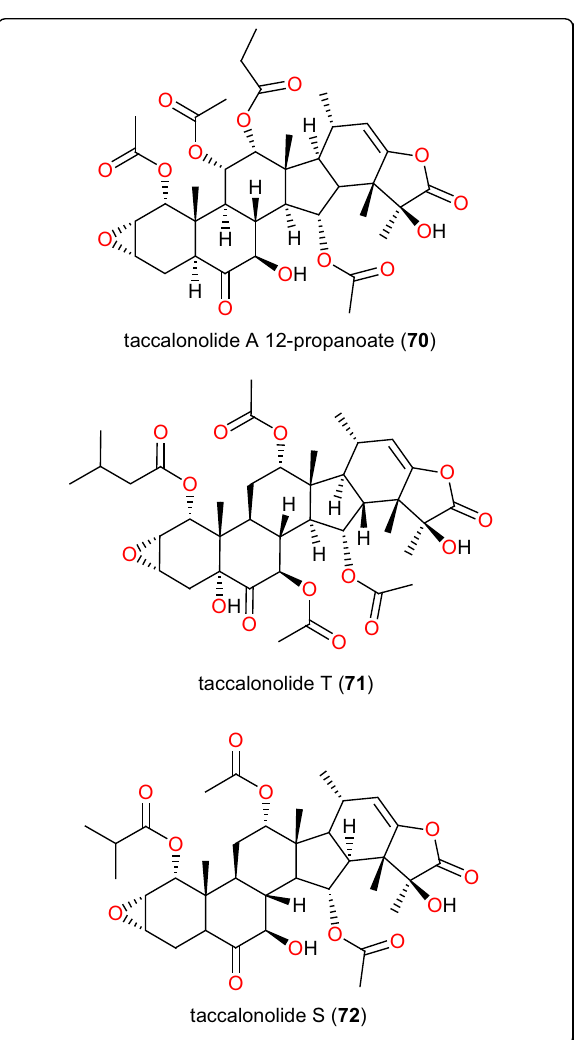
Fig. 13 Taccalonolides, a rare class of